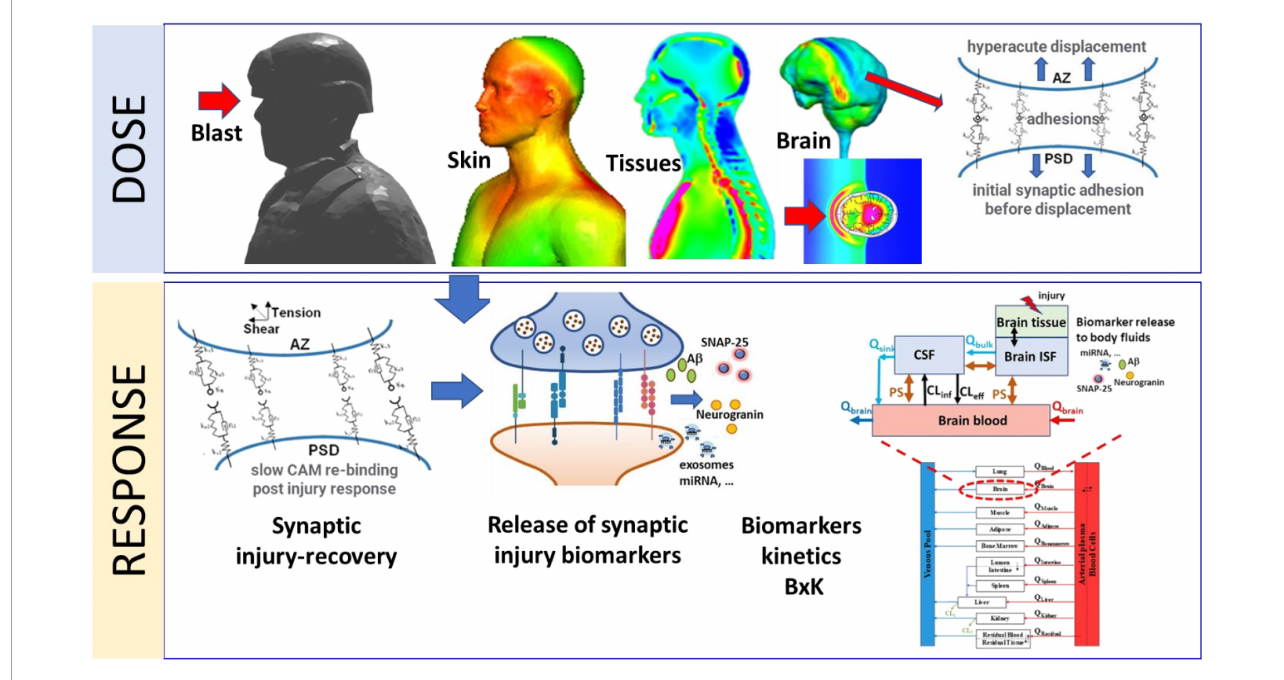
FIGURE1 Schematic representation of major components of the Dose-Response modeling framework for blast induced synaptic brain injury and biomarkers kinetics. The Dose module computes blast induced brain macro-biomechanics and the hyper-acute micro-mechanics of synaptic adhesion molecules. The Response module simulates kinetics of synaptic cell adhesion molecules, synaptic damage/repair, release of synaptic biomarkers into CNS fluids and their whole-body kinetics (BxK).